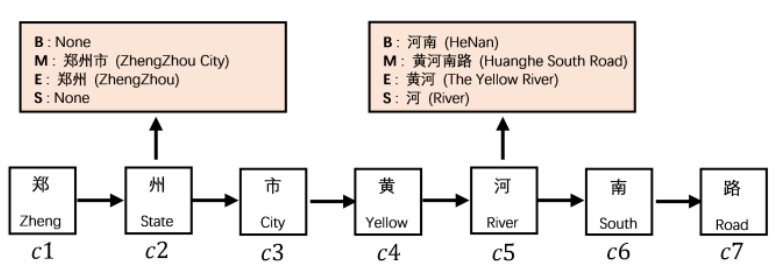
Figure 2. An example of generating the “BMES” word set [13]. The input sentence is “ 郑 州 市 黄 河 南 路 ” (Zhengzhou Huanghe South Road). The light orange boxes are the “BMES” word sets of the characters “ 州 ” (state) and “ 河 ”